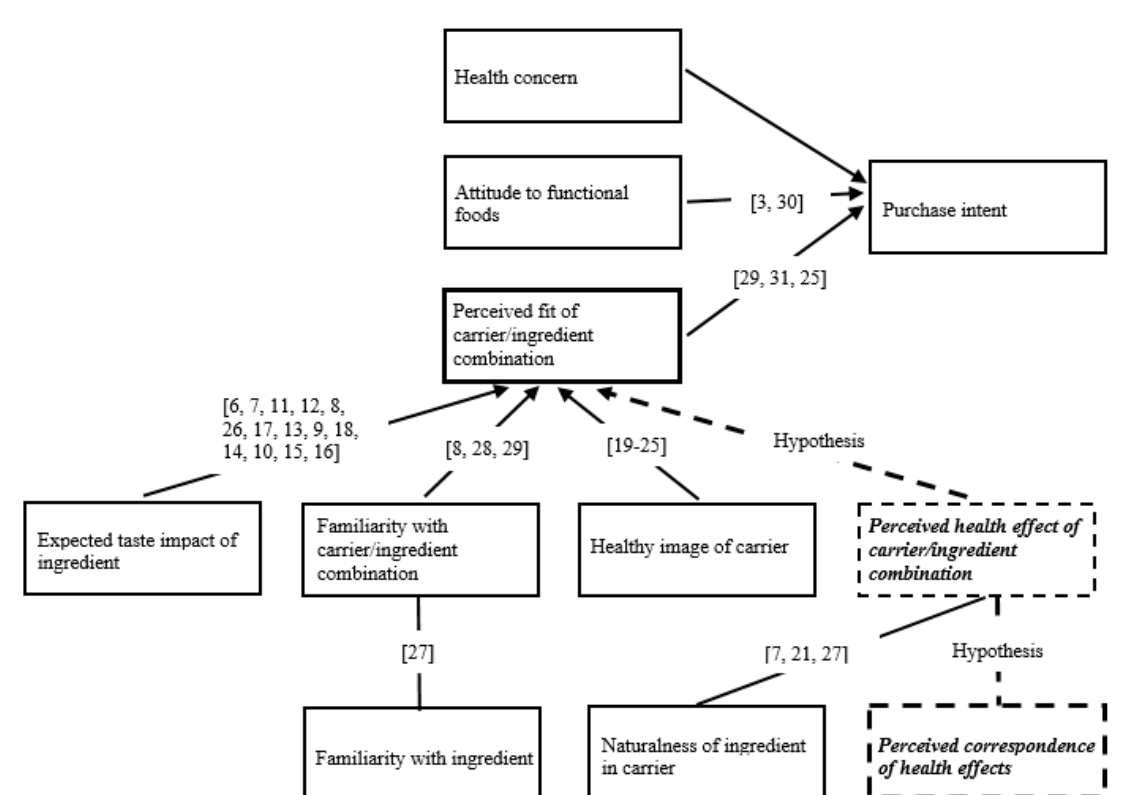
Figure 1. Determinants (confirmed and hypothesized) influencing purchase intent for functional